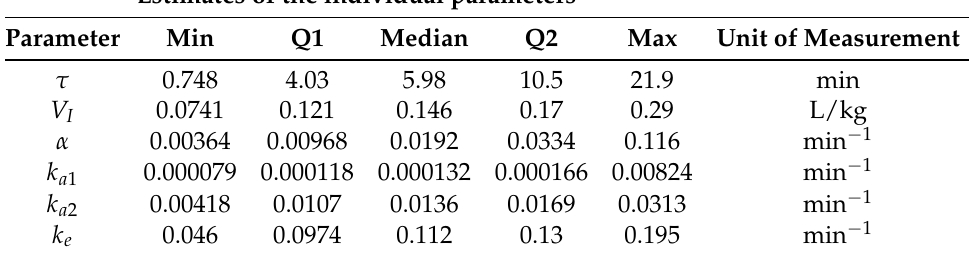
Table 3. Summary of the individual parameter distributions obtained from model identification. From left to right: the minimum, the first quartile (25%), the median, the third quartile (75%), and the maximum